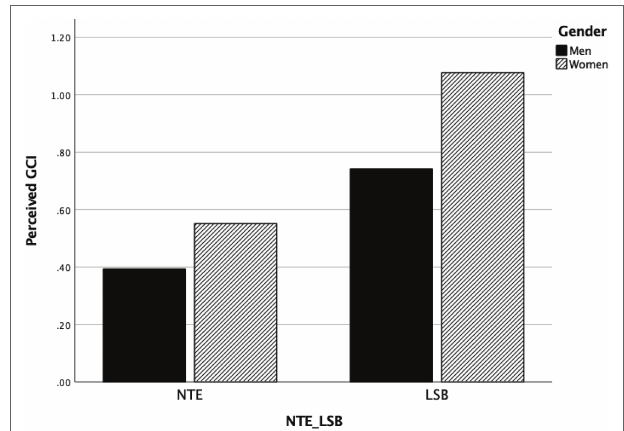
FIGURE 3 | Two-way interaction effect Field (NTE vs. LSB) × Gender (Men vs. Women) on Perceived